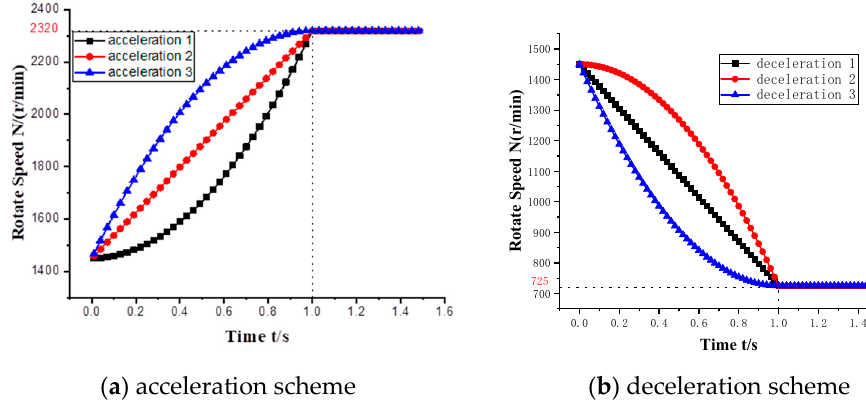
Figure 4. Acceleration and deceleration scheme.